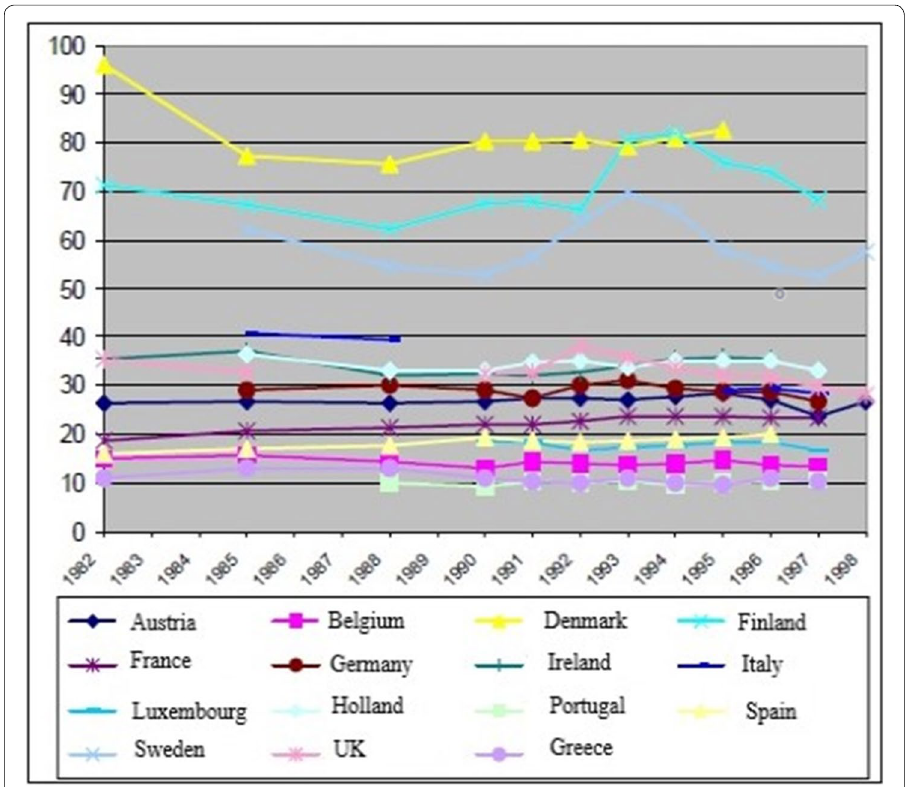
Fig. 2 Percentage of local government revenue in central government revenue Source: